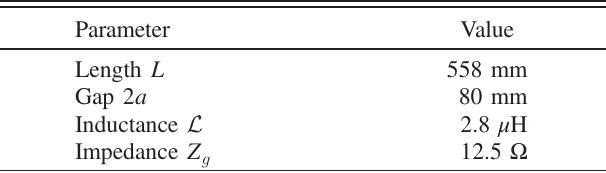
TABLE II. The main parameters of one extraction kicker module in the BRing.